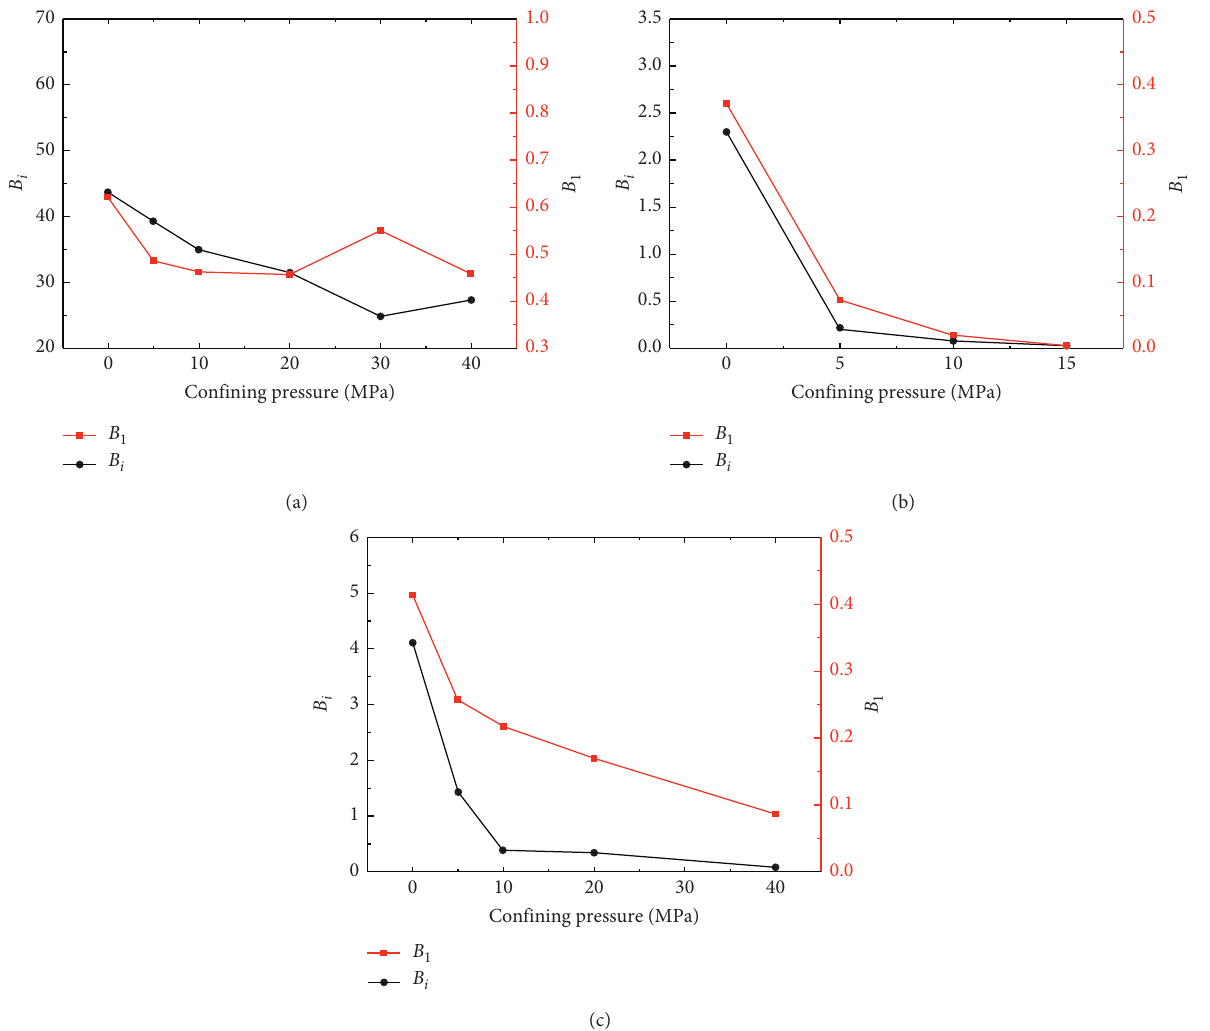
Figure 4: Variation tendency of B (c) T2b